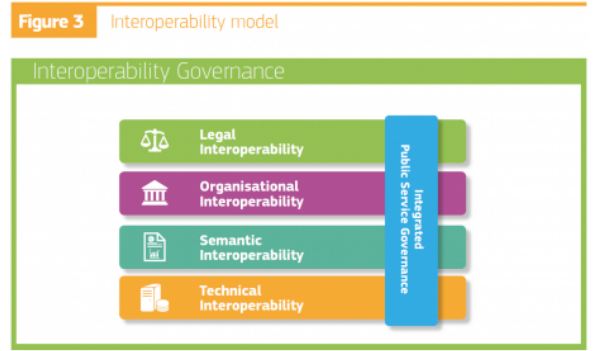
Figure 5. Interoperability Layers Perspective